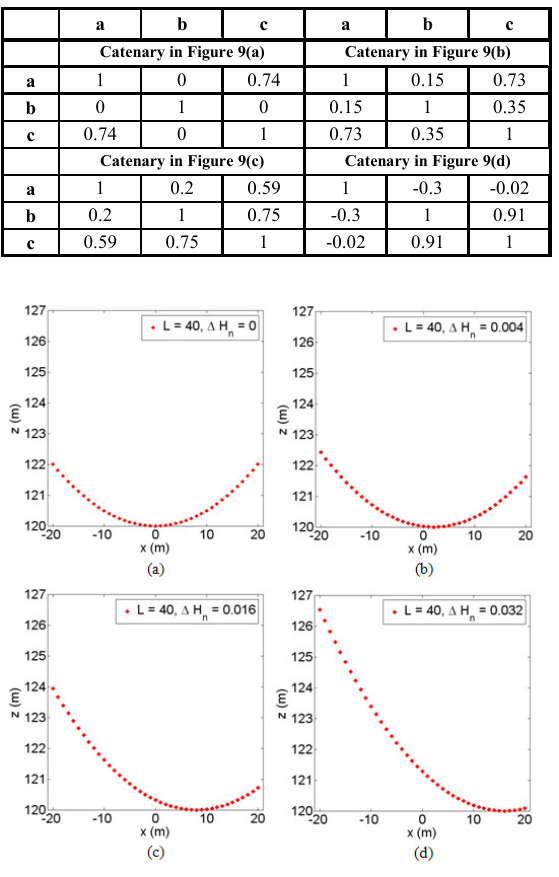
Figure 9. Height difference and symmetry of the catenary curve